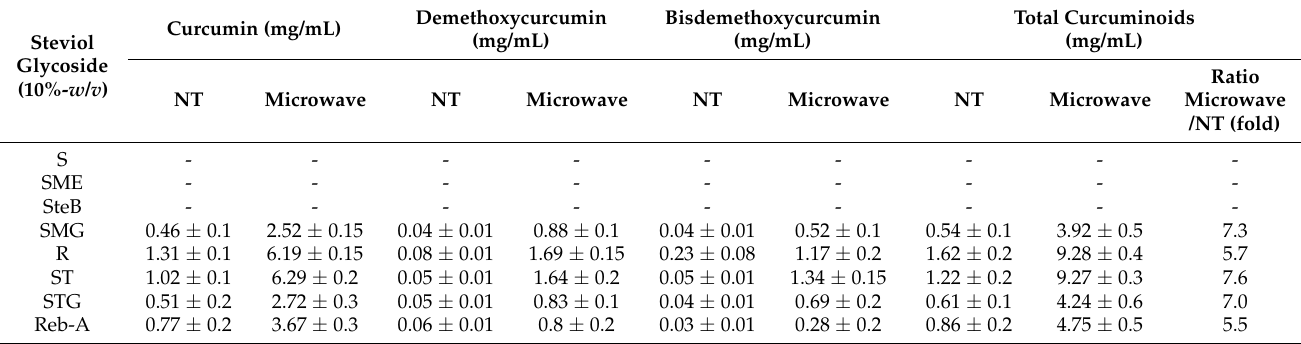
Each curcuminoid was quantified by high-performance liquid chromatography, as described in the methods. NT, not treated by microwave; S, steviol; SME, steviol mono-glucosyl ester; SteB, steviolbioside; SMG, steviol mono-glucoside; R, rubusoside; ST, stevioside; STG, α -glucosyl stevioside; Reb-A,